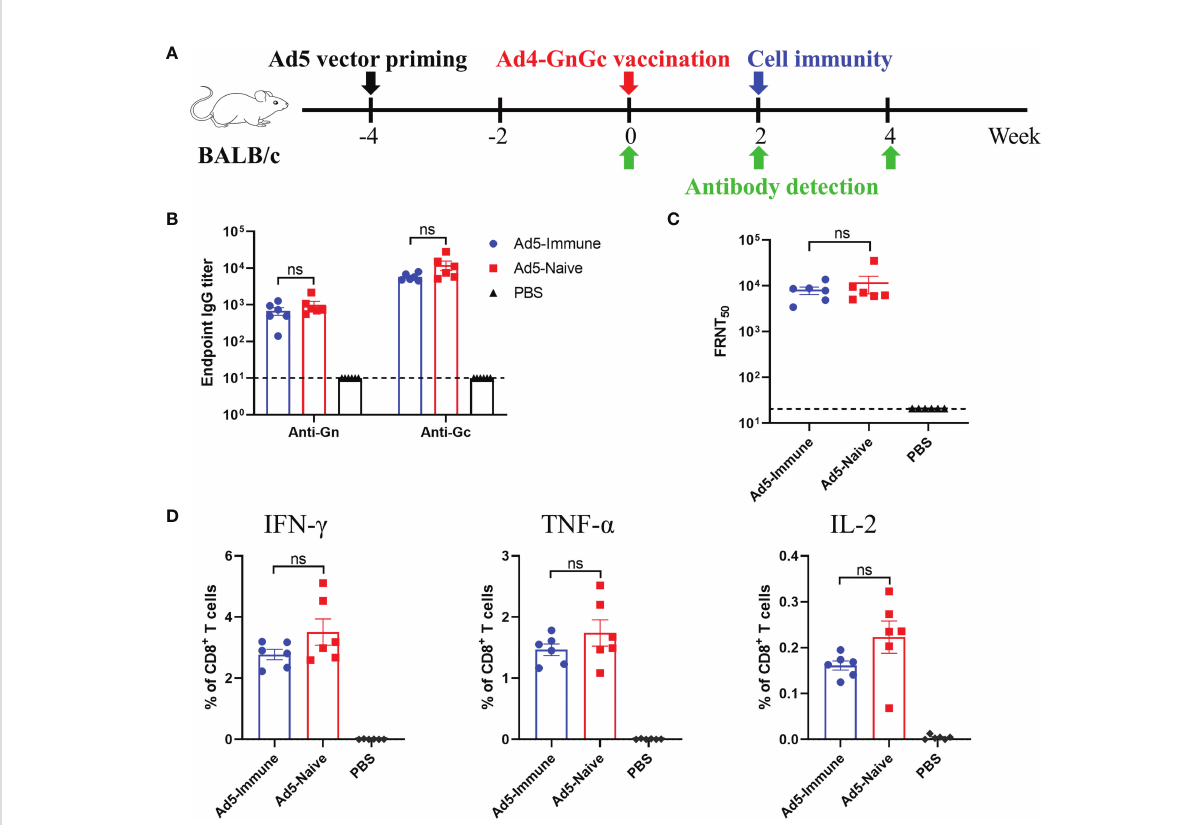
FIGURE 5 Pre-existing immunity to Ad5 has no effect on the ef fi cacy of Ad4-GnGc. BALB/c mice (n = 12) were primed with 10 8 IFU of Ad5 vector at week -4 by intramuscular injection to induce anti-vector immune responses. Naive animals were maintained as vector-naive controls. On week 0, animals were vaccinated intramuscularly with 10 8 IFU of Ad4-GnGc, and PBS-treated mice were maintained as a negative control. In each group, six mice were used for serum collection at different time after immunization for binding antibody or neutralizing antibody detection, and the other six mice were used for cytokine detection. (A) Schematic of the experimental design. (B) Serum collected on day 14 after Ad4-GnGc immunization was used to measure RVFV Gn- and Gc-speci fi c IgG antibody titers. (C) Four weeks after vaccination, serum neutralizing antibody titers were determined using infectious RVFV by the FRNT. (D) Two weeks after Ad4-GnGc vaccination, six mice from each group were sacri fi ced and the splenocytes were collected to determine the percentages of IFN- g -, TNF- a - and IL-2-secreting CD8 + T cells by ICCS. Data are shown as the mean ± SEM. Signi fi cance was calculated using an unpaired Student ’ s t test. n.s., not signi fi